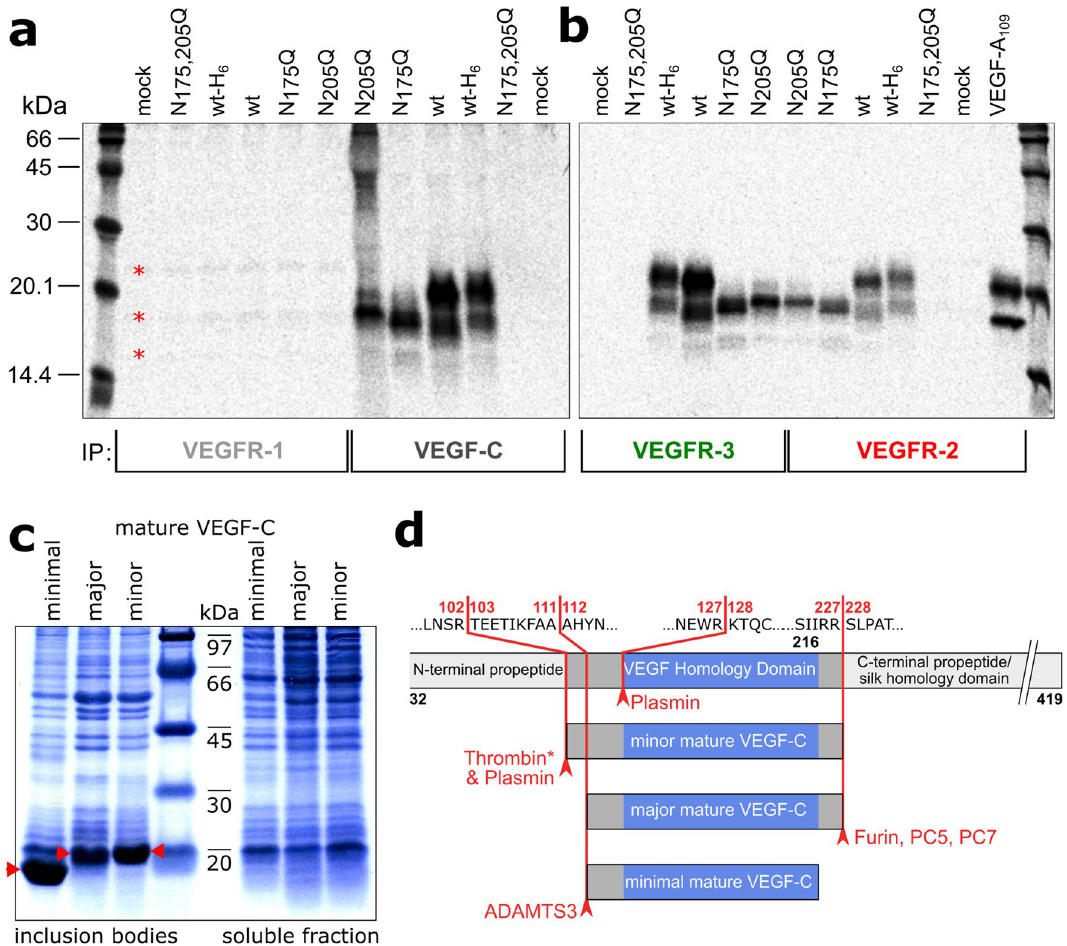
Figure 2. Single glycosylation mutants of mature VEGF-C expressed in 293T cells can bind VEGFR-2 and VEGFR-3, but mature VEGF-C aggregates into inclusion bodies when expressed in E. coli BL21 (DE3). ( a , b ) Immunoprecipitation (IP) of [ 35 S]-labeled VEGF-C from media of 293T cells transfected with the indicated single and double glycosylation mutants of VEGF-C. The equivalent N > W glycosylation mutants gave identical results (Supplementary Fig. S1). Note that when VEGFR-1 binding is studied, the isoforms of VEGF-A endogenously expressed by 293T cell result in 3 distinct faint bands (marked by asterisks). ( c ) Coomassie- stained PAGE gel of the cytoplasmic inclusion body fraction and the cytoplasmic soluble fraction. None of the inclusion body fractions or the soluble fractions show any biological activity. The expected sizes for the minimal, major, and minor mature VEGF-C are ~ 11.8 kDa, ~ 13.2 kDa, and ~ 14.2 kDa, respectively, which are denoted by red arrows. ( d ) Schematic of the truncation mutants and how they relate to the naturally occurring proteolytically generated mature forms of